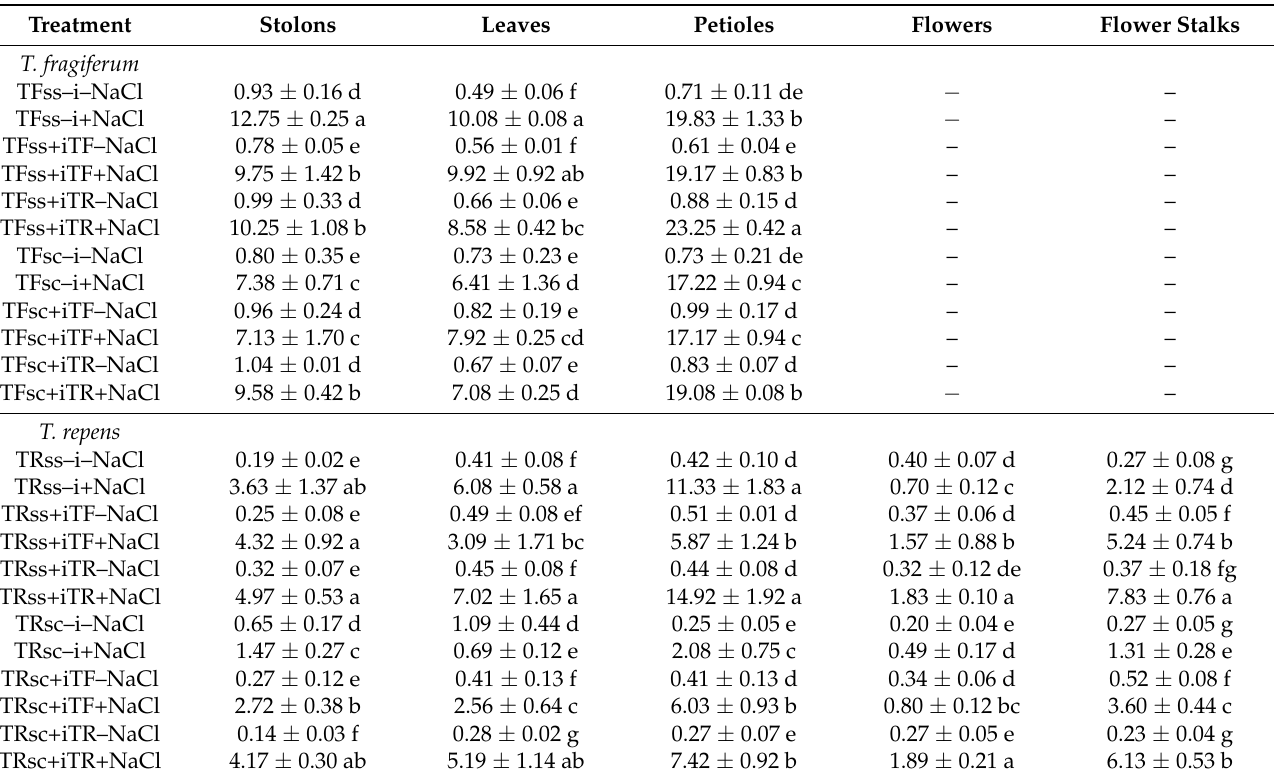
Table 10. Tissue Na + concentration (g kg − 1 DM) in different parts of T. fragiferum and T. repens at the harvest. Treatment Stolons Leaves Petioles Flowers Flower